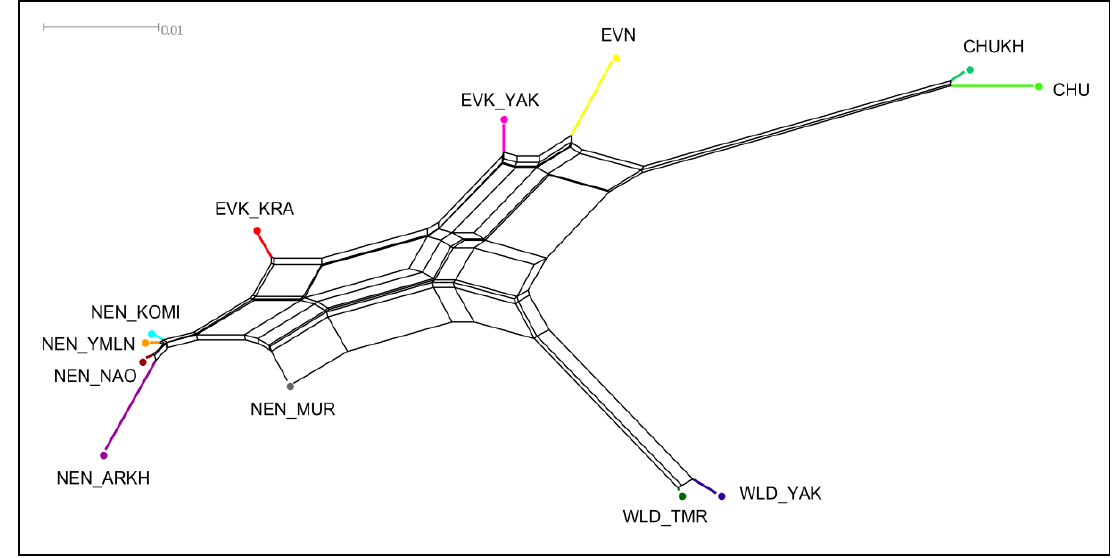
Figure 2. Neighbor-net tree of the Russian reindeer breeds based on pairwise F ST values. CHU, Chukotka; CHUKH, Chukotka–Khargin; EVN, Even; EVK_YAK, Evenk of the Yakutia region;